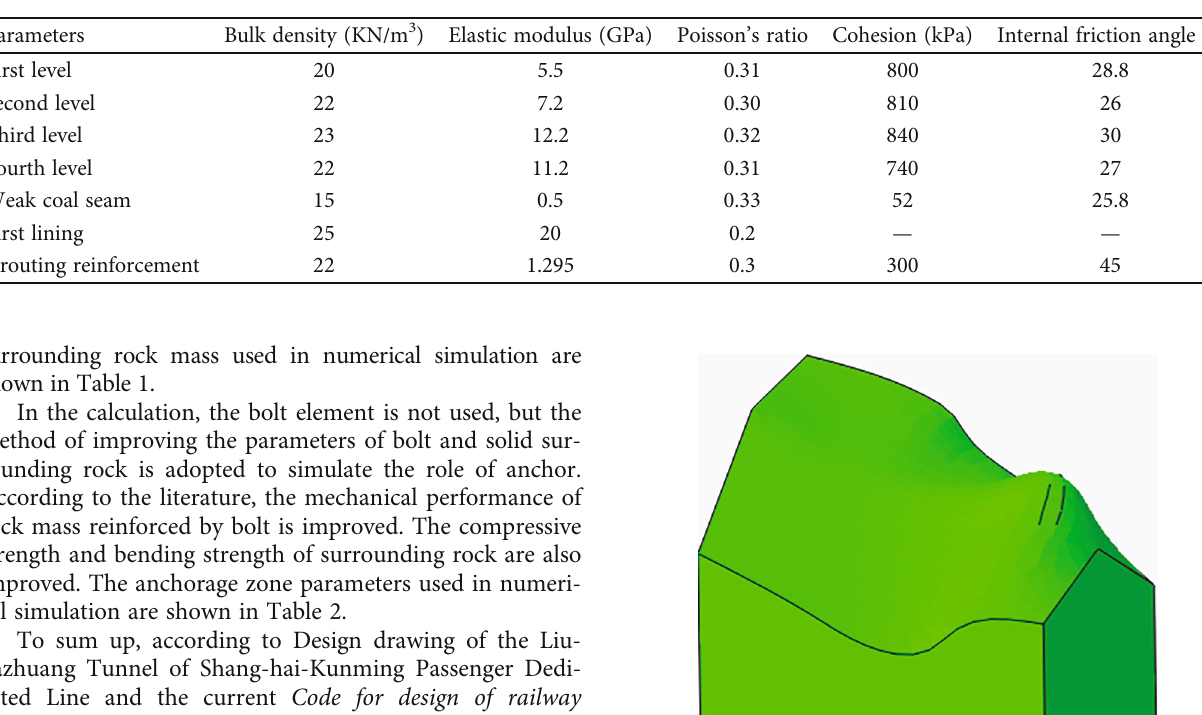
Table 3: Physical and mechanical parameters of surrounding rock layers.